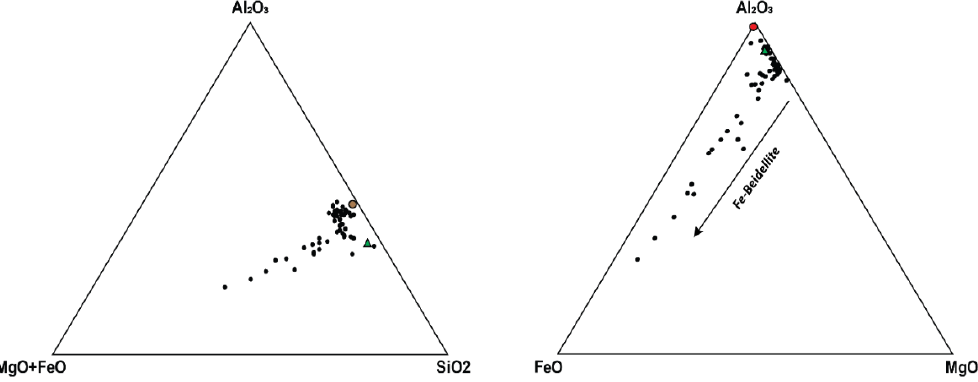
Figure 16. Ternary diagrams illustrating the distribution of clays within the samples. This distribution indicates iron enrichment of the clays toward a Fe-beidellite pole. Kaolinite (pink dot) and beidellite (green triangle) poles are also shown.